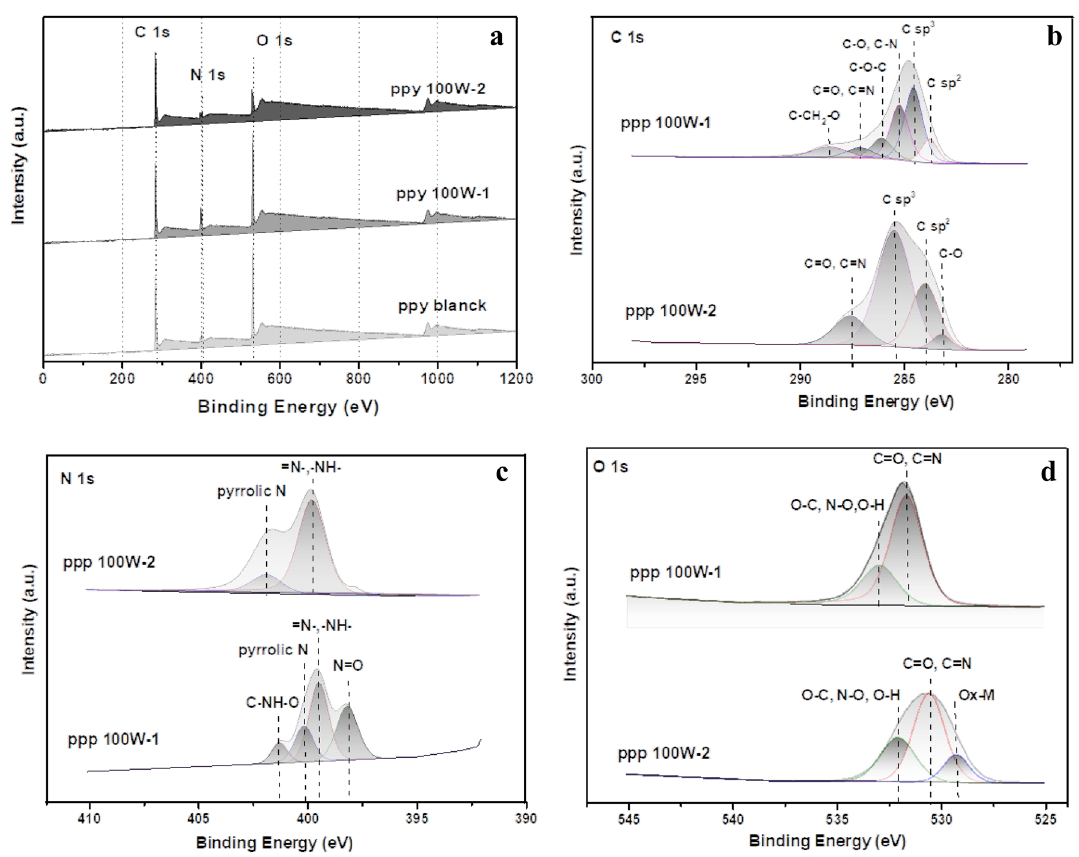
in the N 1 s region for ppy 100W-1 and ppy 100W-2 and d high-res- olution spectrum in the O 1 s region in ppy 100W-1 and ppy 100W-2